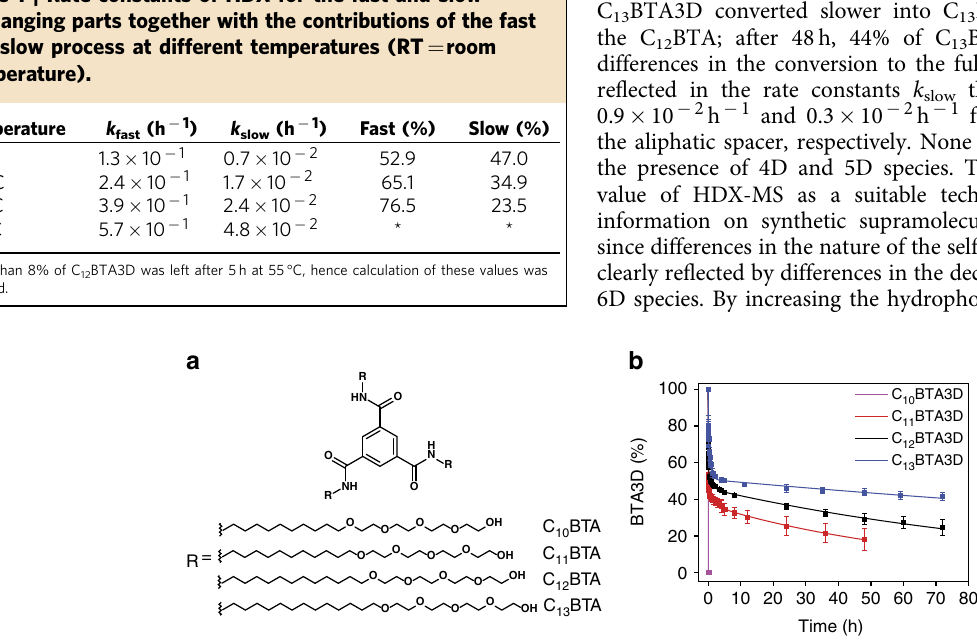
Figure 5 | Structure-dependent exchange kinetics. ( a ) Molecular structure of C 10 BTA, C 11 BTA, C 12 BTA and C 13 BTA. ( b ) Corresponding percentages of BTA3D as a function of time after the dilution of the 500 m M BTA solutions 100 times into D 2 O. Lines are tri-exponential fits of the data, and the error bars represent one s.d. of uncertainty computed from three separate kinetic